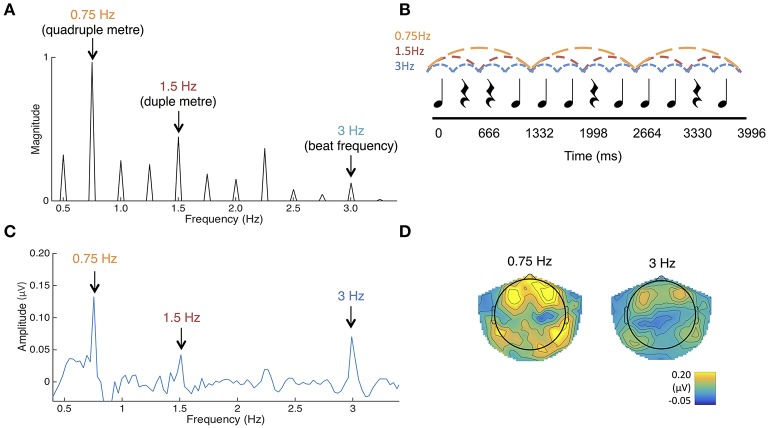
(A) The frequency spectrum of the stimulus sound envelope. (B) The rhythmic pattern, which consisted of 333 ms long tones and rests. Each tone consisted of 990 Hz pure tones with 10 ms rise and fall times. (C) Average SS-EPs with noise subtracted amplitudes averaged across all channels. Peaks can be visualized at the quadruple meter frequency (0.75 Hz) and beat frequency (3 Hz). (D) Average topographical map of the SS-EPs elicited at the quadruple meter frequency (0.75 Hz) and beat frequency (3 Hz), averaged across all participants.